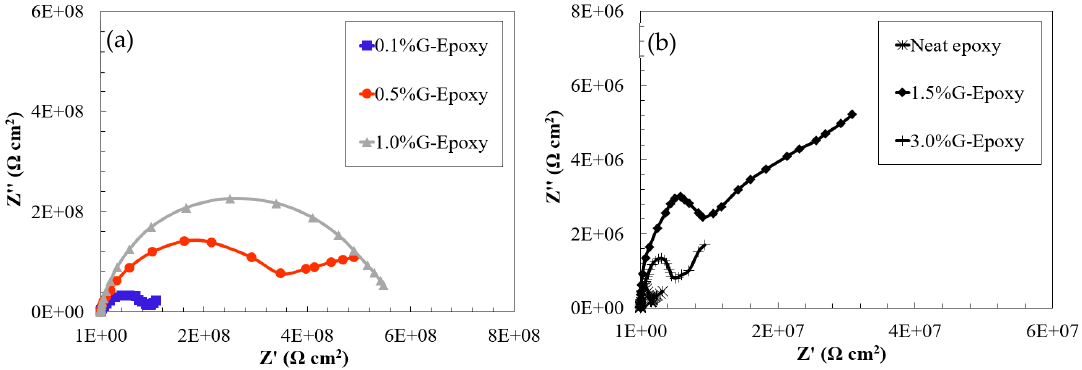
Figure 9. Nyquist plots for the test samples after 200 h exposure: ( a ) 0.1–1.0%G-Epoxy and ( b ) 1.5–3.0%G-Epoxy and the reference.